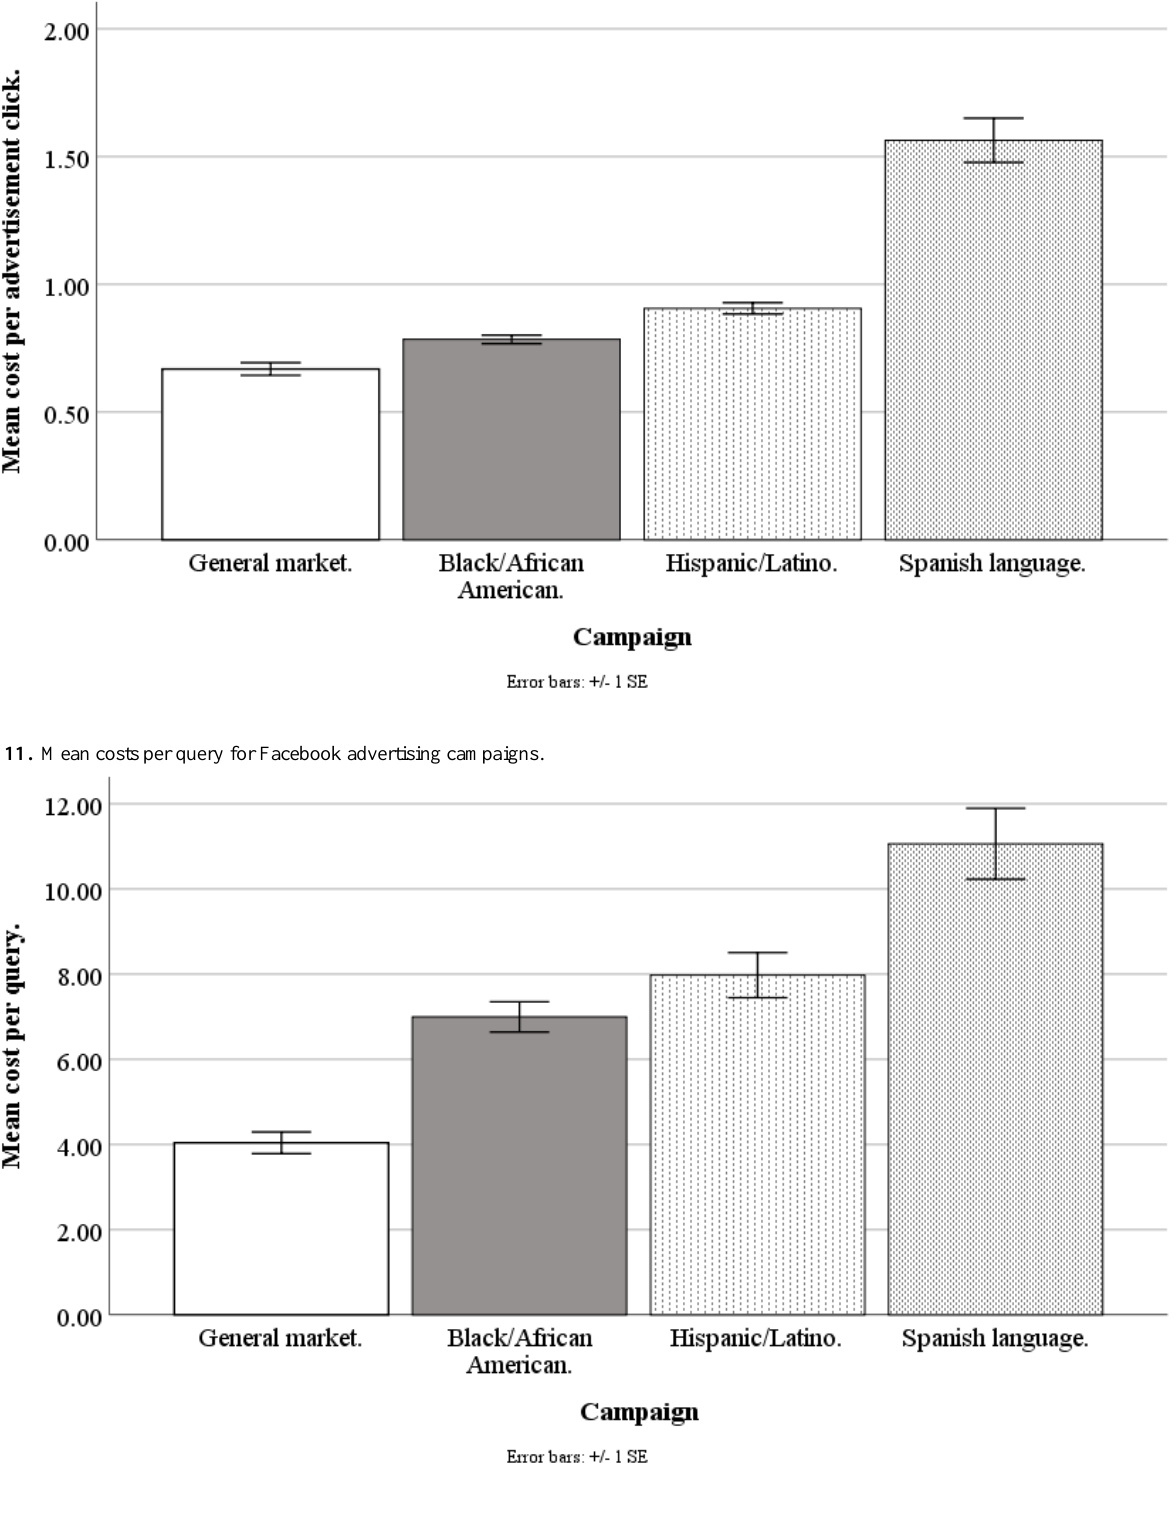
Figure 10. Mean costs per advertisement click for Facebook advertising campaigns.